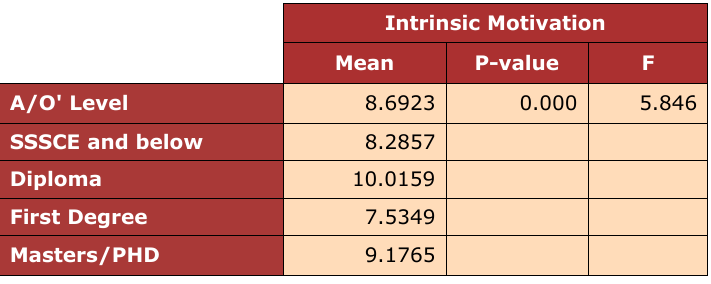
Table 6. Intrinsic motivation across Educational Levels [One-Way Analysis of Variance